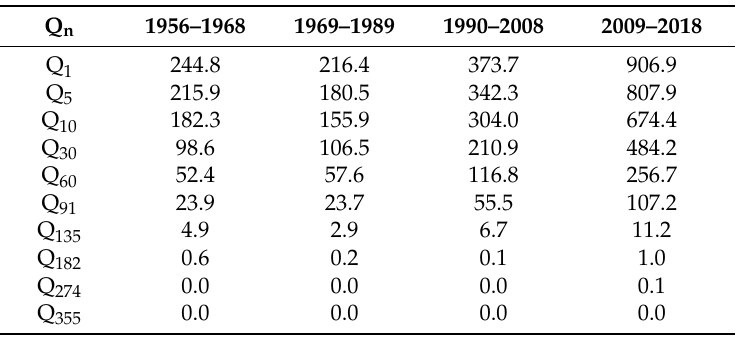
Table 6. Characteristic discharge (m 3 /s) for the FDC set of Figure 7b.